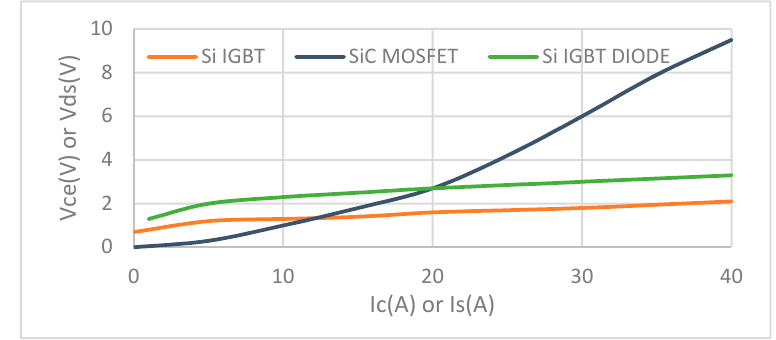
Figure 5. Typical output characteristics of Si IGBT and its anti-parallel diode and SiC MOSFET.